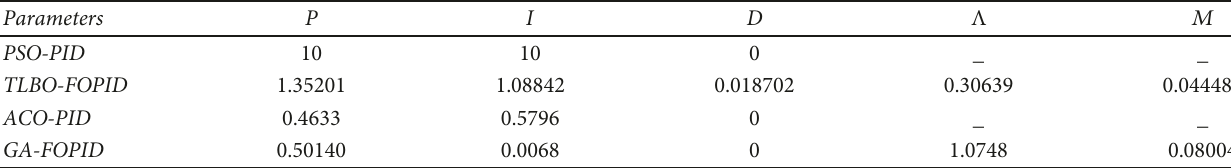
Table 4: Controller parameters of i